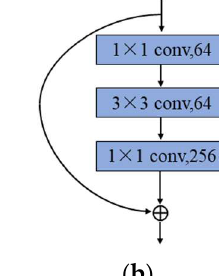
Figure 4. T-LeNet network module ( a ) and time‒frequency feature extraction network module ( b ). In ( a ), it contains seven network layers. In ( b ), from Stage1 to Stage4, each module contains a Conv Block (located in the first block) and multiple Identity Blocks.